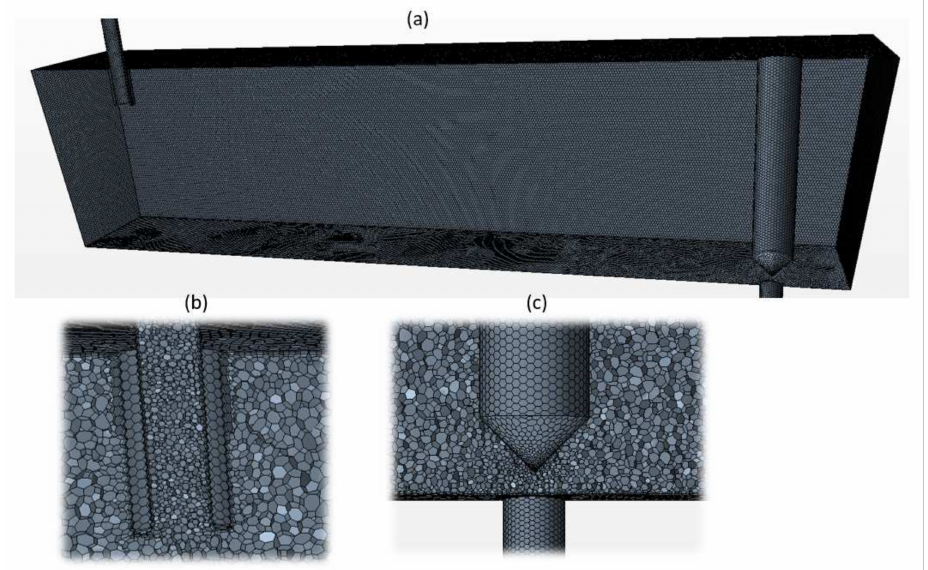
Figure 2. CFD Mesh, ( a ) full water model tundish, ( b ) zoom in of inlet part, ( c ) zoom in of stopper rod and